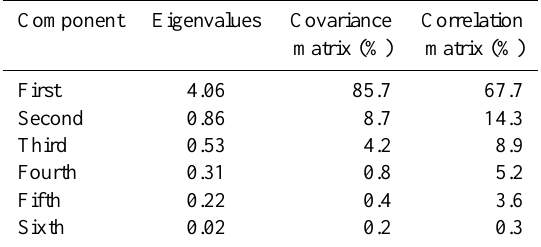
Table 1. The Hydrological characteristics and observation at the observation wells.